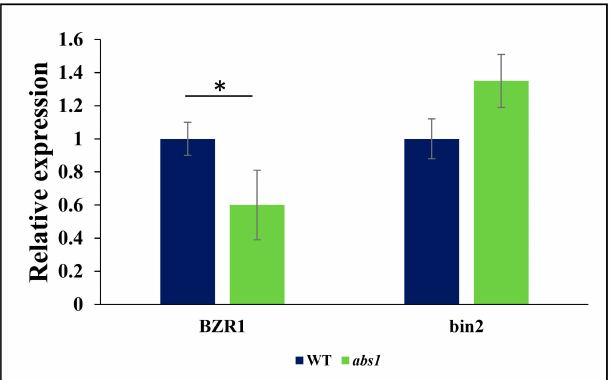
Figure 2. Relative expression of BR-signaling components. The relative mRNA expression of BR- signaling components in WT (wild-type) and abs1 fruits by qRT-PCR. The experiment was carried out using three biological and three technical replicates, and the values are presented as relative expression. The error bar represents the standard error. Asterisk indicates significant differences (*: p ≤ 0.05, Student’s t -test).